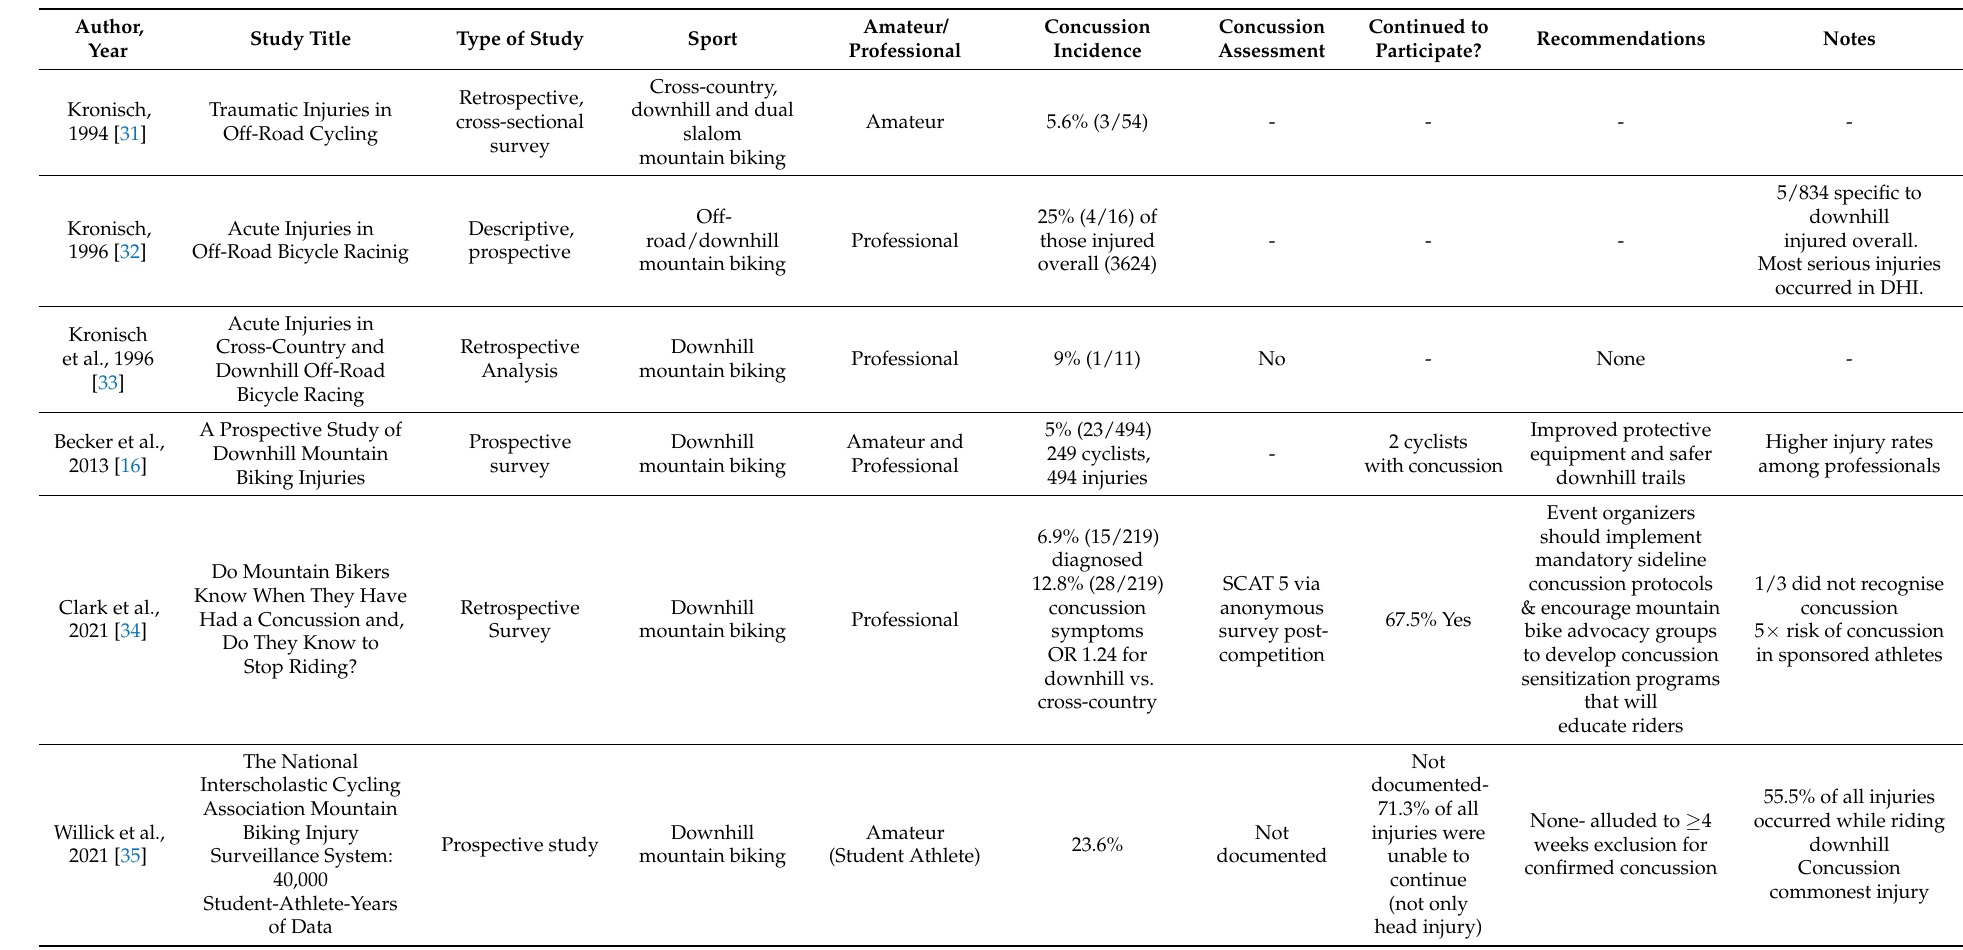
Table 1. Characteristics of Included